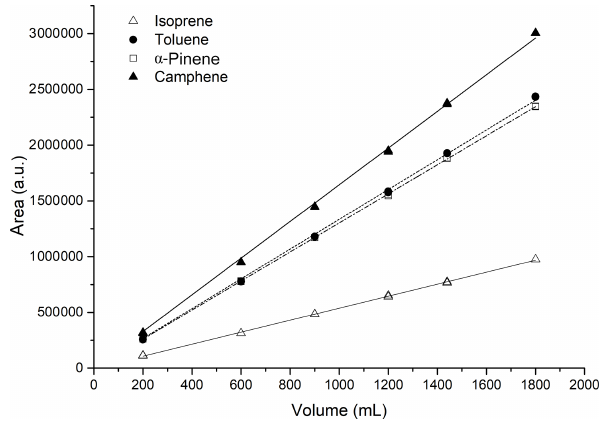
Figure 4. Investigation of the safe sampling volume at 80% RH for the four most volatile compounds in the mixture.